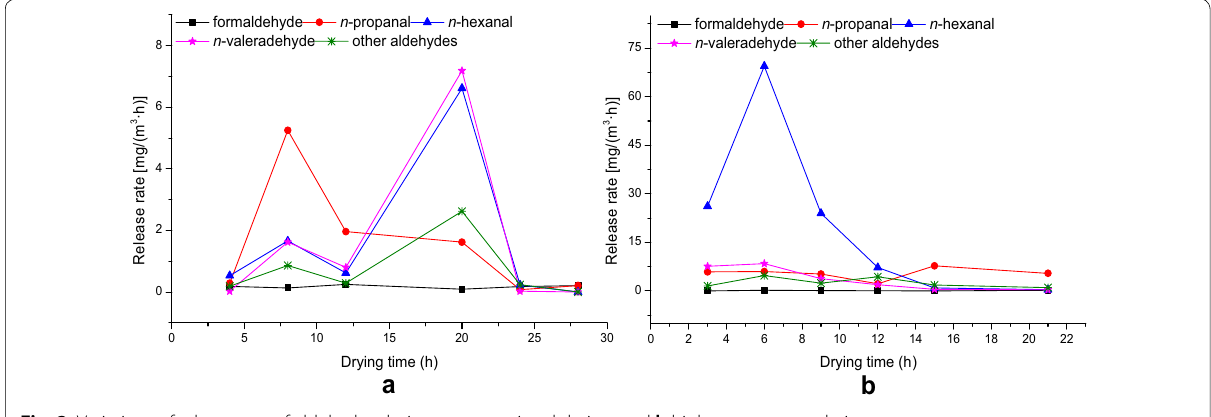
Fig. 2 Variations of release rate of aldehydes during a conventional drying, and b high-temperature drying